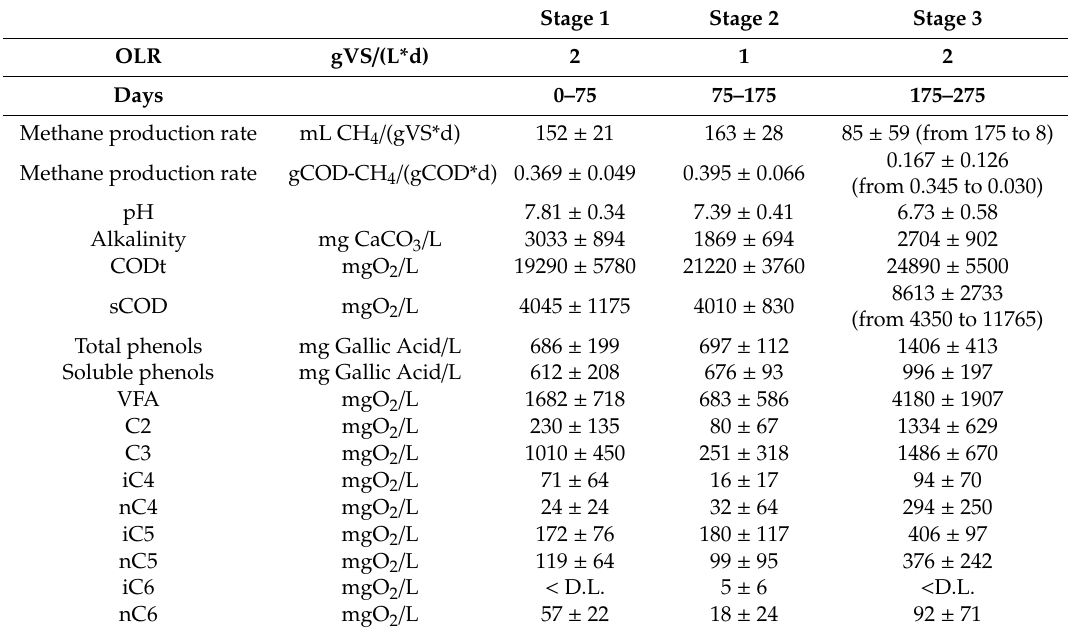
Table 3. Methane production rates, pH, alkalinity, COD, CODs, total phenols, soluble phenols, total VFA and individual phenolic compound concentration during the di ff erent organic loading rates